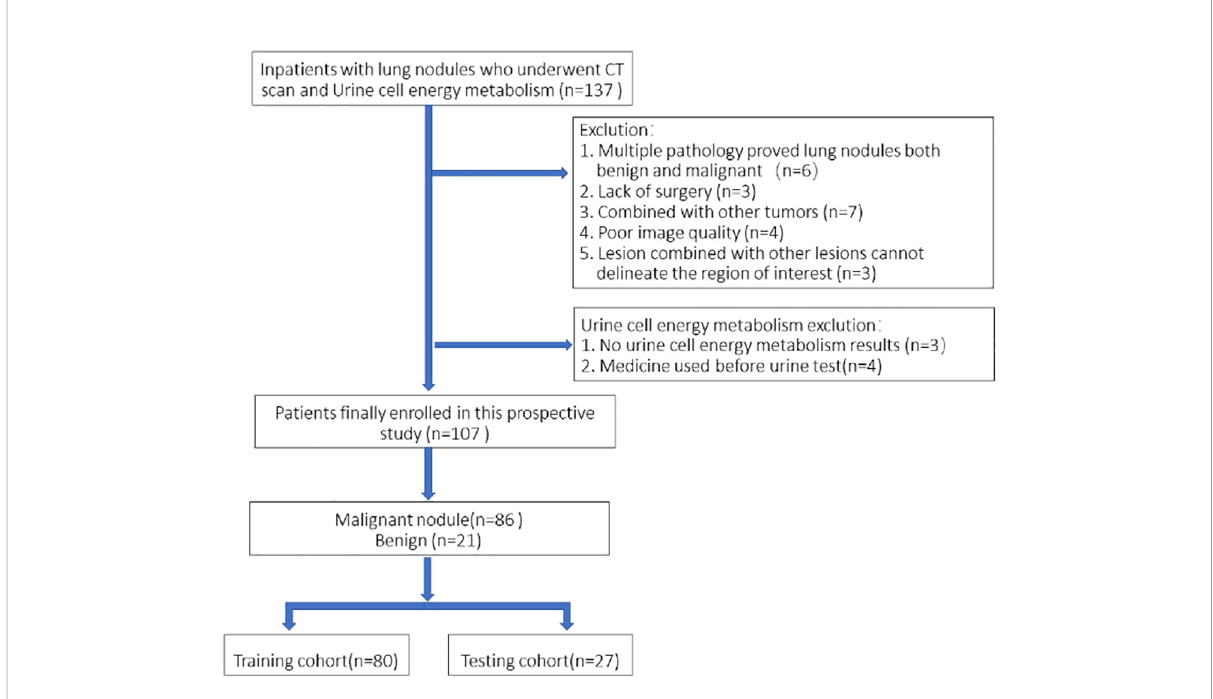
FIGURE 1 Flowchart of the study subjects based on exclusion